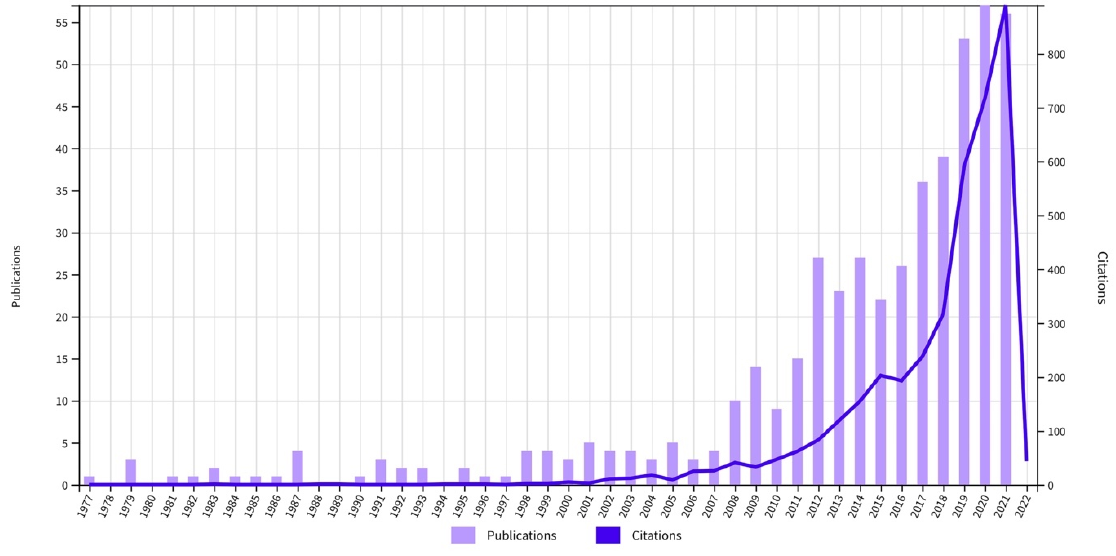
Figure 2. Evolution of publications and citations over time.